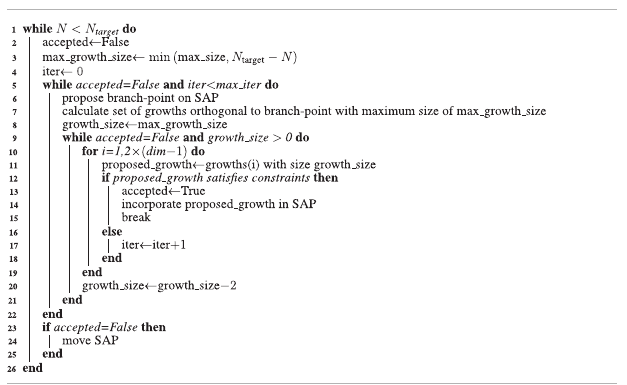
Algorithm 1 | SAP-Growth